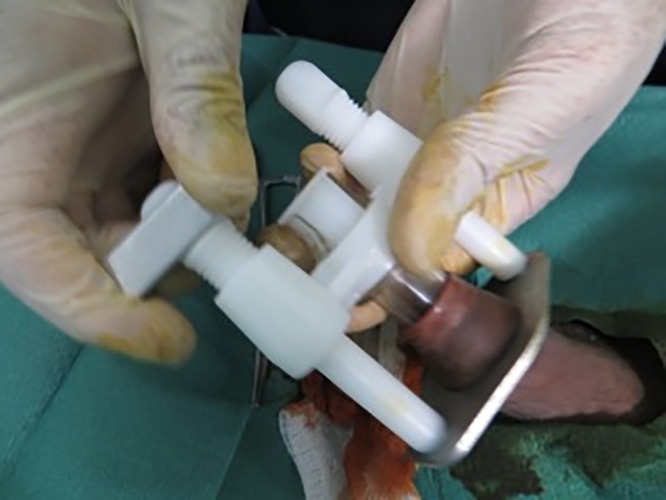
Unicirc placement.